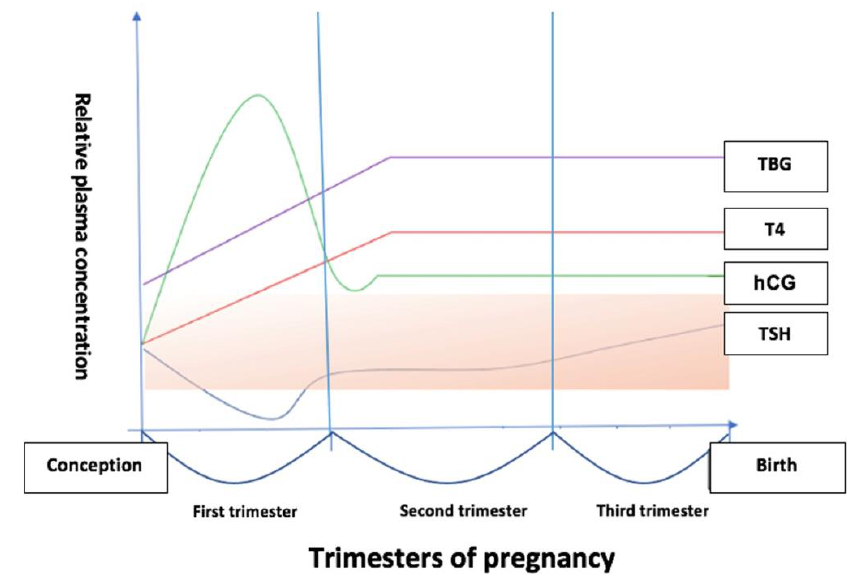
Figure 2. Changes in the plasma concentration of thyroid hormones and hCG in pregnancy. The orange surface corresponds to the normal reference range for non-pregnant women (hCG—human chorionic gonadotrophin; TBG—thyroid-binding globulin; T4—thyroxine; TSH—thyroid-stimulating hormone) [15].